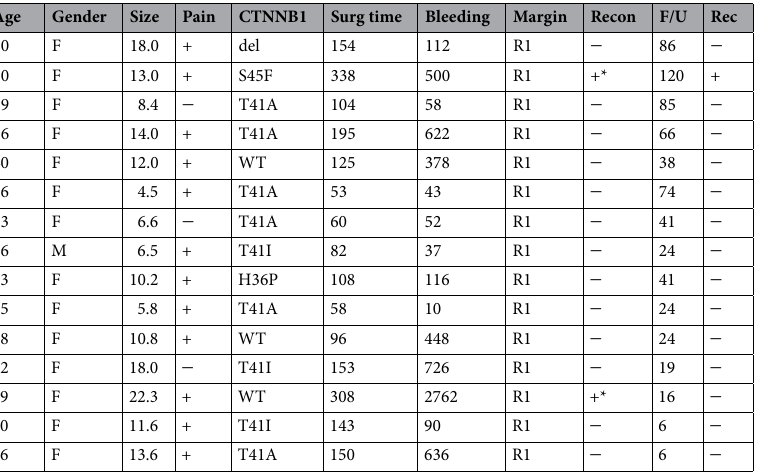
Table 1. Patients with abdominal wall desmoid treated with tumor excision. Age at surgery, Size maximum diameter of tumor (cm), CTNNB1 mutation type, Surg time surgery time (minutes), Bleeding intraoperative bleeding volume, Margin microscopic surgical margin, Recon plastic reconstruction after tumor excision, F/U follow up duration (months), Rec recurrence, F female, M male, del deletion, p.Ser45_Gly48del with whole exome sequencing, *Patch with fascia